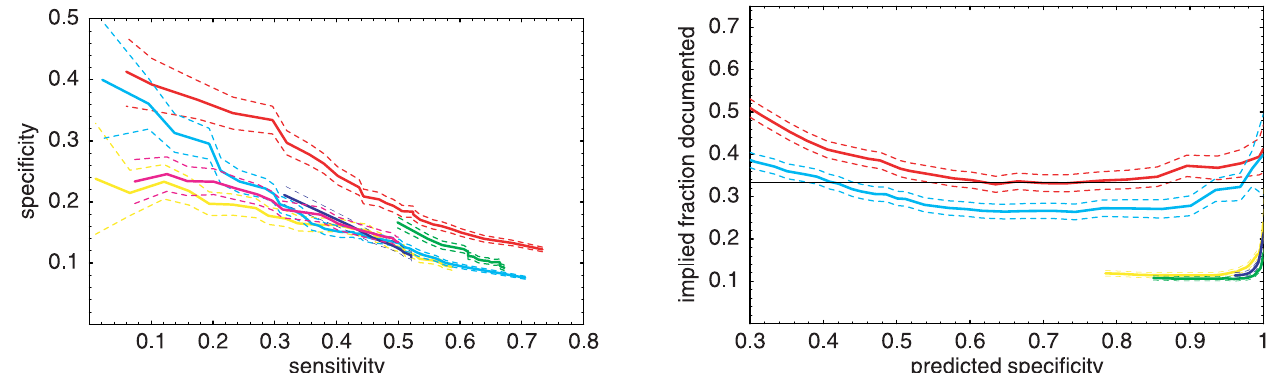
Figure 6. Performance of Several Motif-Finding Algorithms on 200 Alignments of Orthologous Intergenic Regions from Five Saccharomyces Species Containing Documented Binding Sites The left panel shows how the fraction of predicted sites that match true sites (specificity) depends on the fraction of true sites that are among the predictions (sensitivity) for PhyloGibbs (red), EMnEM (yellow), PhyME (green), PhyloGibbs without phylogeny (light blue), WGibbs (dark blue), and MEME (pink). Dashed lines correspond to one standard error. In order for the specificities, predicted by the various algorithms, to match the true specificities, we have to assume that the known sites are only a fraction of all true sites. The right panel shows what the fraction of known sites among all true sites should be in order for the algorithms’ predicted specificities to match the true specificities. The black line shows an independent estimate of the fraction of real sites in these upstream regions that is documented (see text). DOI: